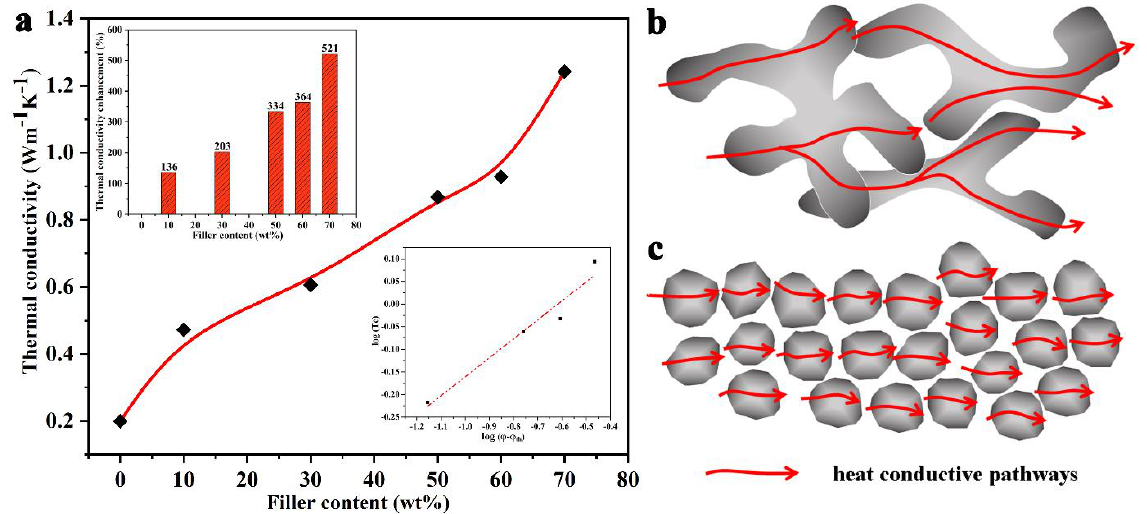
Figure 4. ( a ) Thermal conductivity of the SR composites filled with different contents of B-Al 2 O 3 and heat conductive pathways of composites with ( b ) B-Al 2 O 3 and ( c ) common irregular